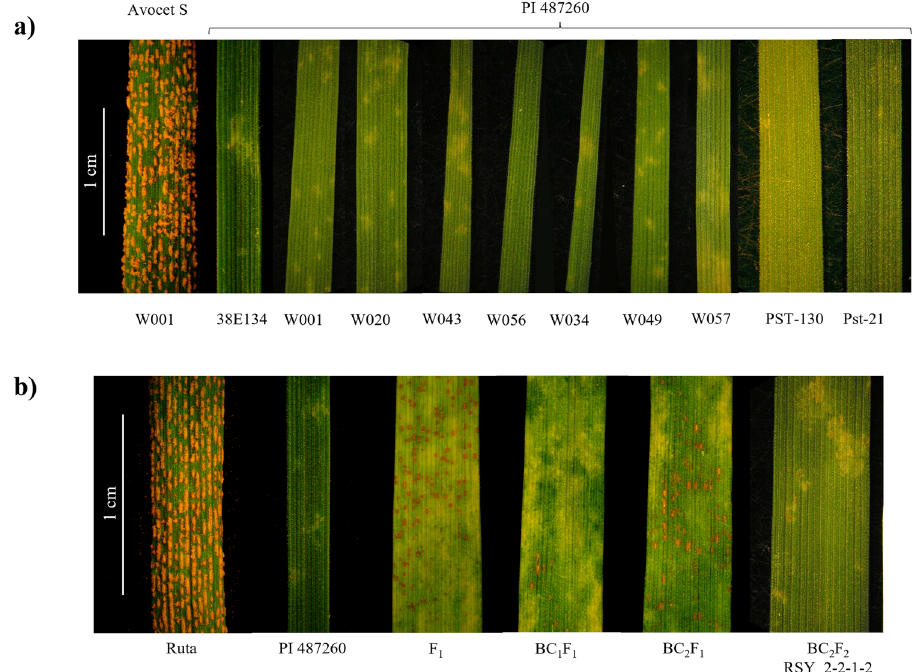
Fig. 1 Phenotypic responses of Yr84 at wild emmer wheat donor line PI 487260 and at different stages of its introgression into cultivated wheat backgrounds to inoculation with stripe rust. a PI 487260 response to inoculation with ten Pst isolates from Israel, Canada and the USA. b Reactions to Pst race W001 observed at multiple fi lial generations of Yr84 introgression into hexaploid bread wheat cv. Ruta. Full resistance is expressed only after Yr84 is fi xed in homozygous state at BC 2 F 2 and following generations.